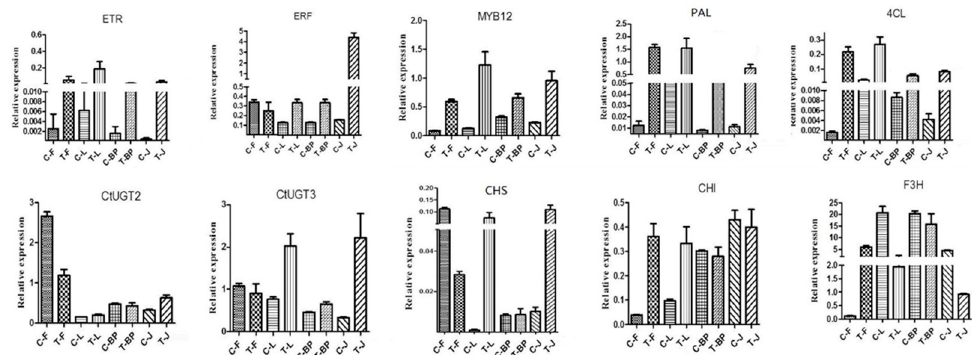
Figure 5. Relative abundance of genes involved in ethylene and flavonoid biosynthesis pathways in flower (F), leaf (L), bracteole (BP) and stem (J) of control (C) and CtACO-overexpressing plants (T).